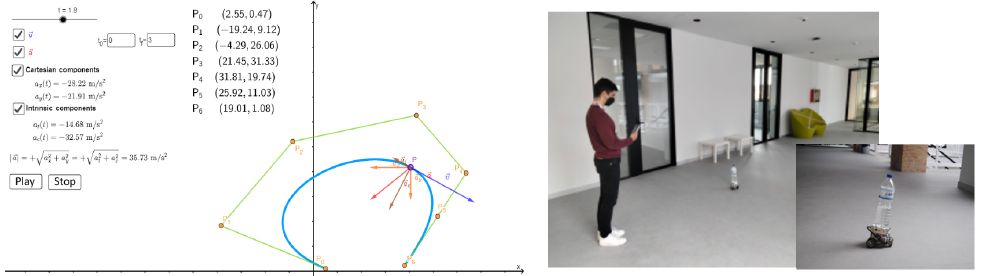
Figure 1. The transport